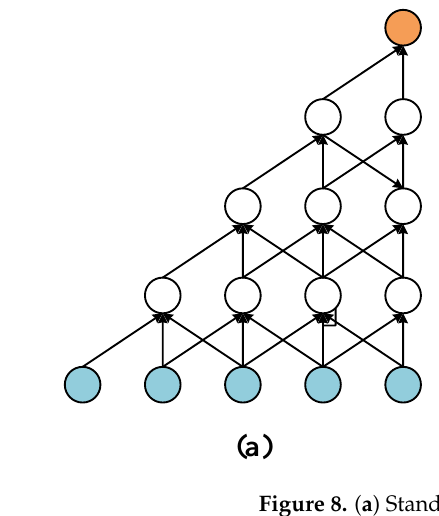
Figure 8. ( a ) Standard Convolution and ( b ) Casual Convolution. Standard convolution does not take the direction of convolution into account. Casual Convolution moves the kernel in one direction.